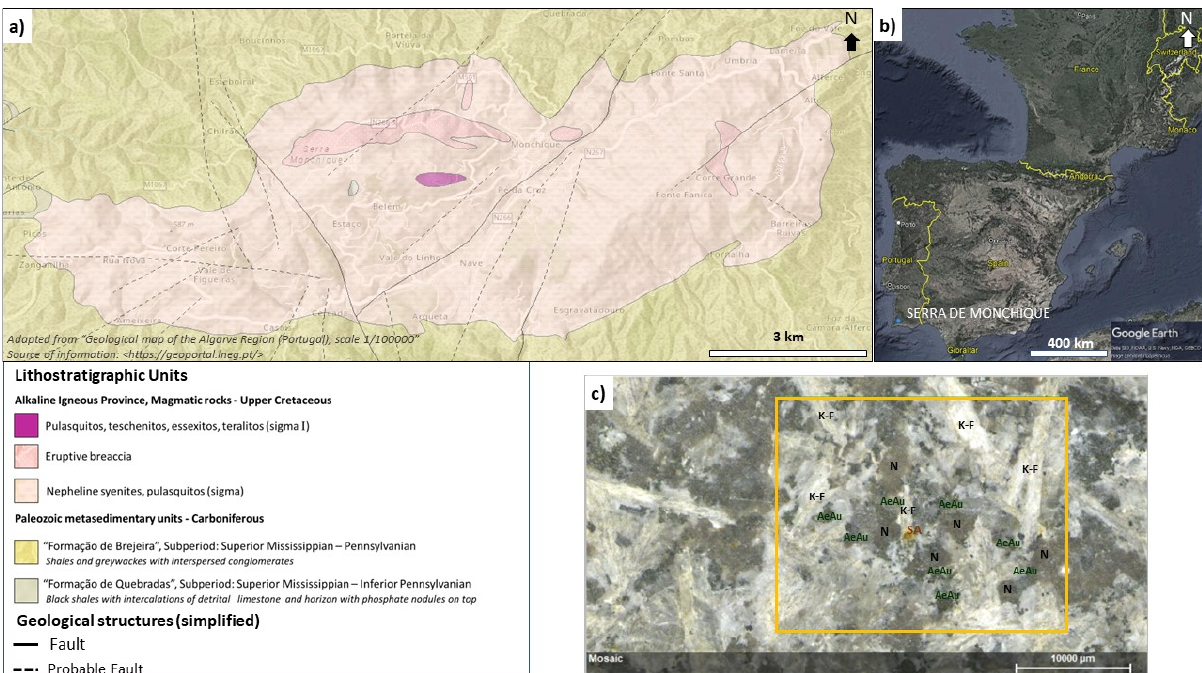
Figure 1. ( a ) Lithostratigraphic units in Serra the Monchique massif and its surroundings and main geological structures (adapted from “Geological Map of the Algarve Region (Portugal), scale 1/100000”, source of information: https://geoportal.lneg.pt/ (accessed on 25 July 2022)); ( b ) Localization of the “Serra de Monchique” massif in the context of southwestern Europe and Iberia; and ( c ) tested sample of the “Serra the Monchique” nepheline syenite (polished surface with indication of the area selected for μ‐ EDXRF surveys) with the indication of some of the occurrences of mineral phases nepheline (N), K ‐ felspar (K ‐ F), and aegirine ‐ augite (Ae ‐ Au). Mineral superficial alteration (SA) is also indicated.